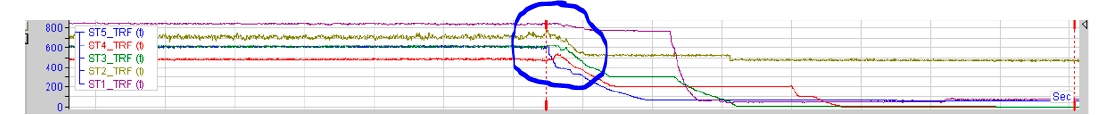
Figure 14. Rolling forces during a strip break.